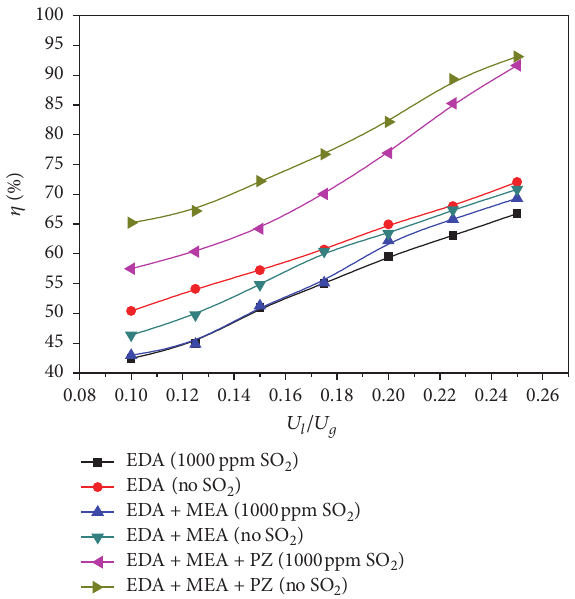
Figure 9: Influence of SO 2 on the CO 2 mass transfer rate in different liquid-gas flow rate ratios ( T = 288 K).